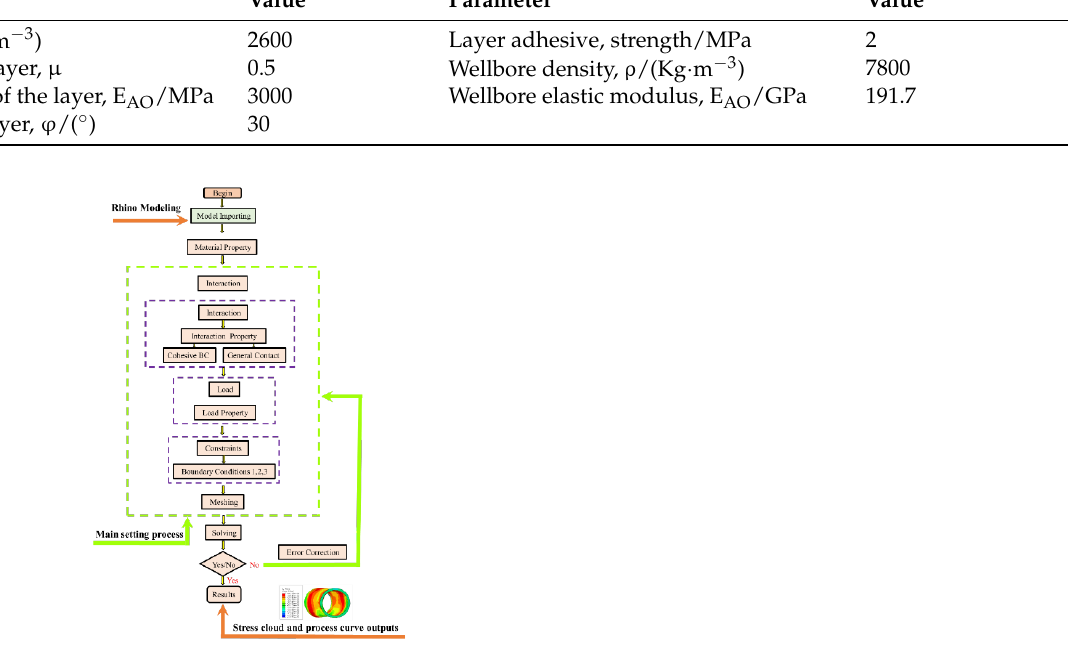
Figure 8. Simulation flow of the wellbore stability stages by ABAQUS analysis.